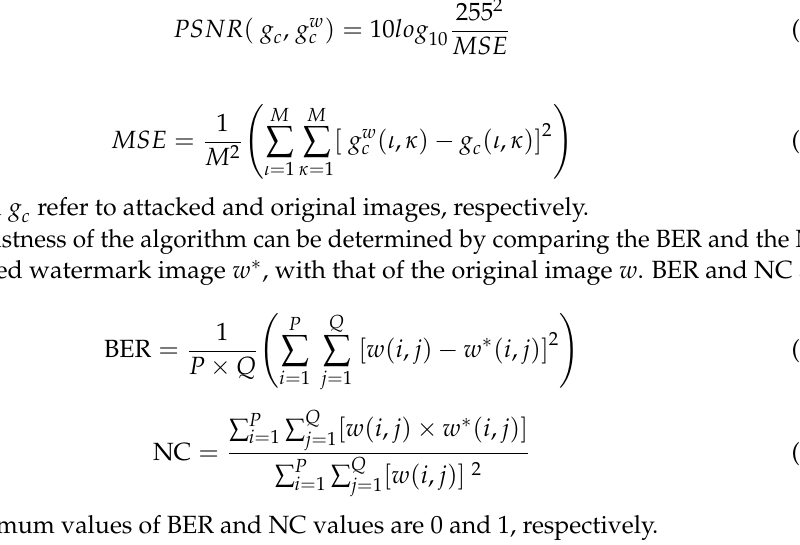
Figure 4. Binary watermarks images.